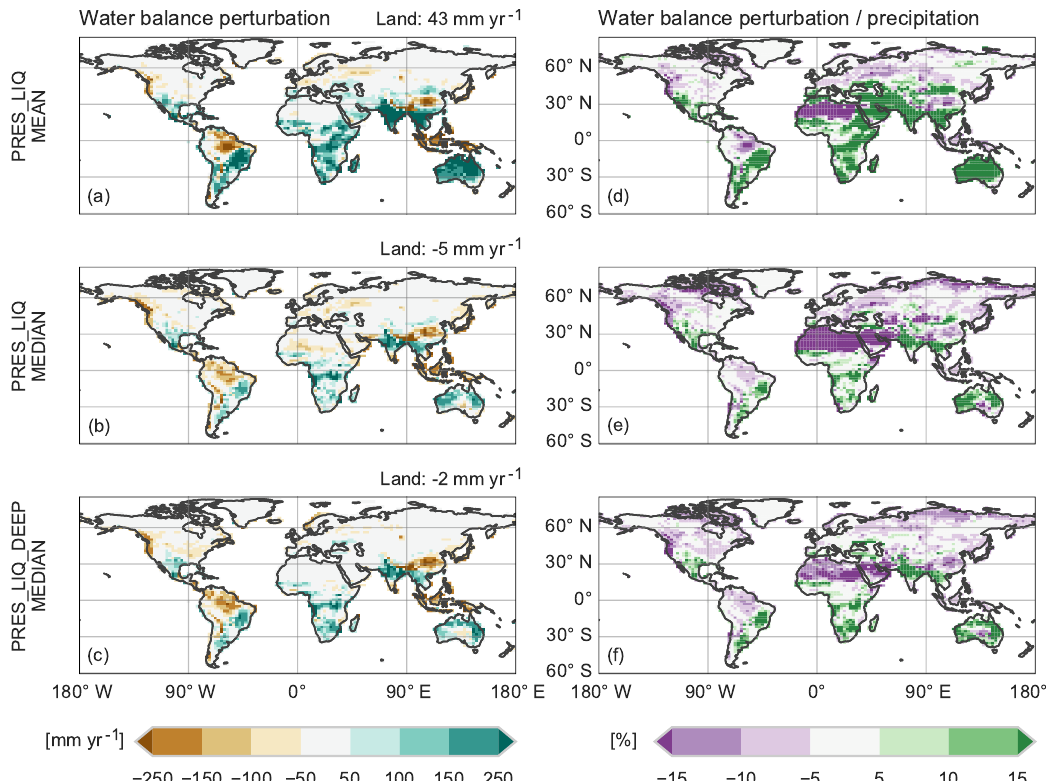
Figure 5. Mean annual SM perturbation for 1971 to 2000. Panels (a) to (c) net water-balance perturbation in mmyear − 1 , panels (d) to (f) net water-balance perturbation scaled by the annual-mean